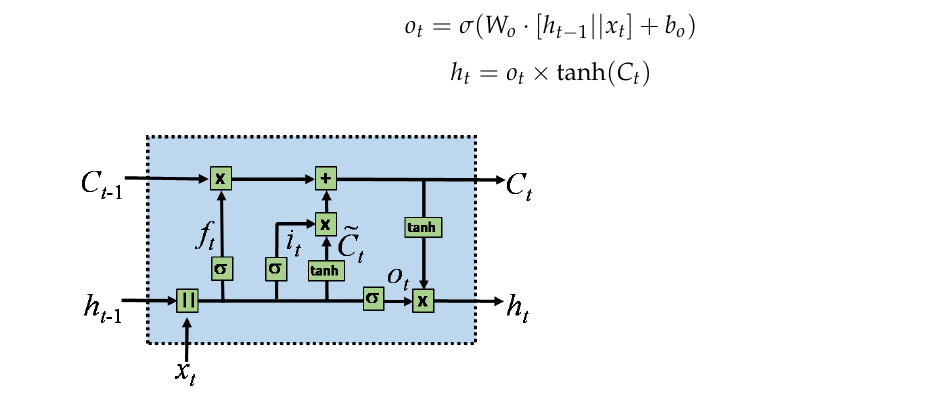
Figure 5. The unit structure of the LSTM neural